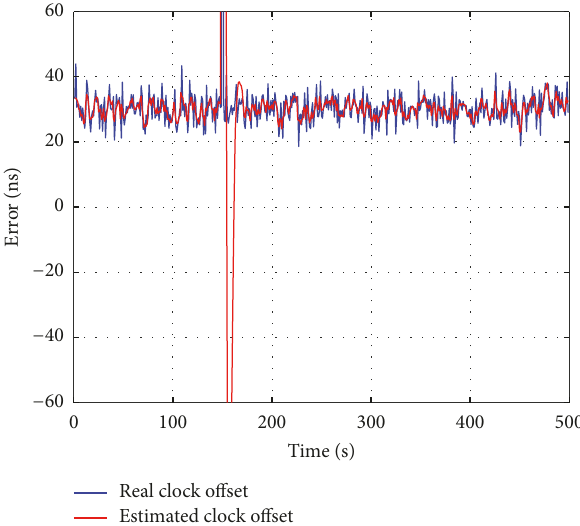
Figure 7: The relative clock offset with big disturbance by Kalman